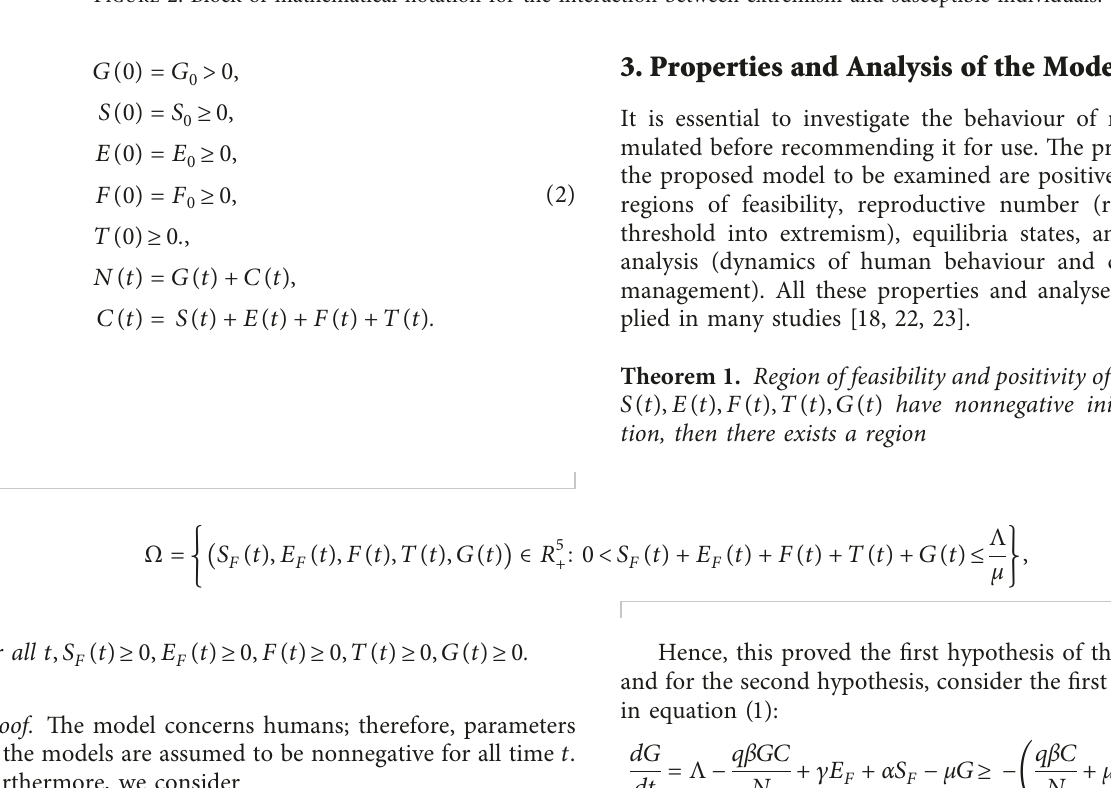
Figure 2: Block of mathematical notation for the interaction between extremism and susceptible